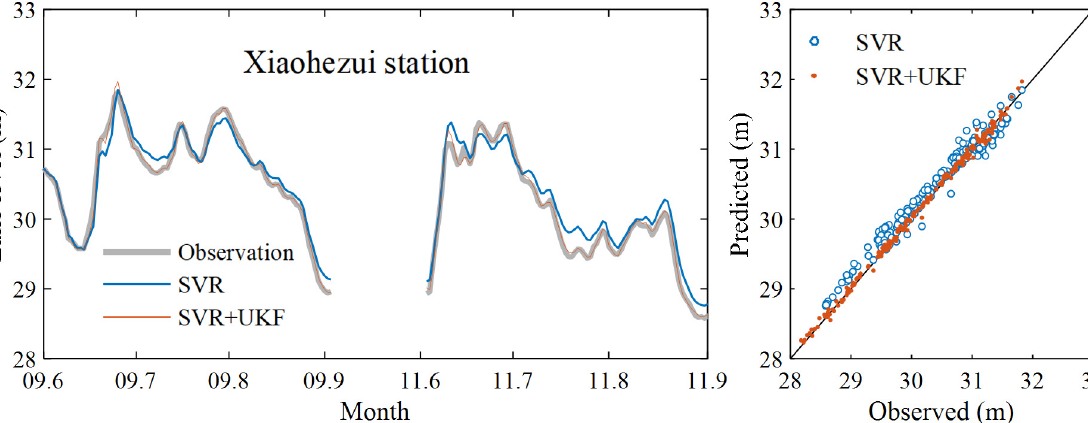
Figure 11. Comparisons between peak water levels in Xiaohezui predicted with SVR and SVR+UKF.